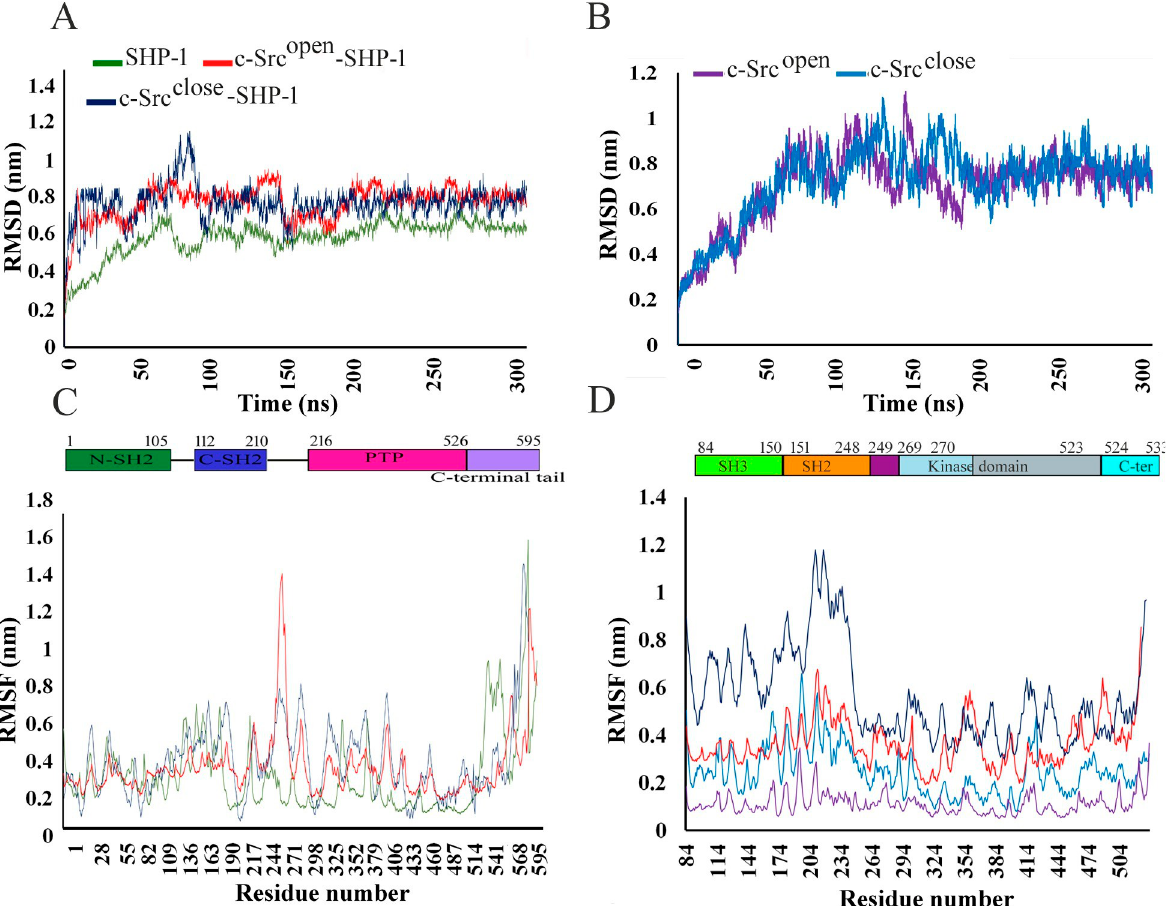
Fig 2. Time-dependent analysis. (A) RMSD plots of apo-SHP-1, c-Src open -SHP-1, and c-Src close -SHP-1 complexes, (B) RMSD plot of apo-c-Src open and apo-c-Src close . (C) RMSF plots over 300 ns for apo-SHP-1 and its bound forms with c-Src open and c-Src close . (D) RMSF plots for apo-c-Src open and c-Src close and its complexes with SHP-1. Apo-SHP-1 (green), c-Src open -SHP-1 (red), c-Src close -SHP-1 (blue), c-Src open (purple), and c-Src close (light